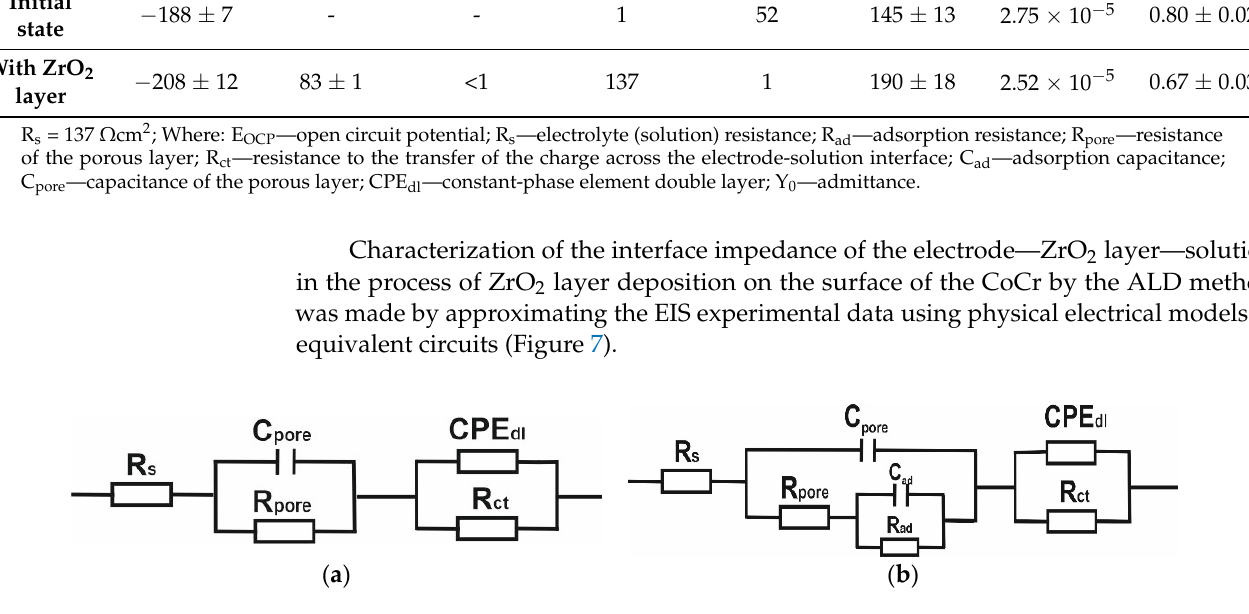
Figure 7. Impedance spectra determined for the samples: ( a ) initial state, ( b ) with ZrO 2 layer.